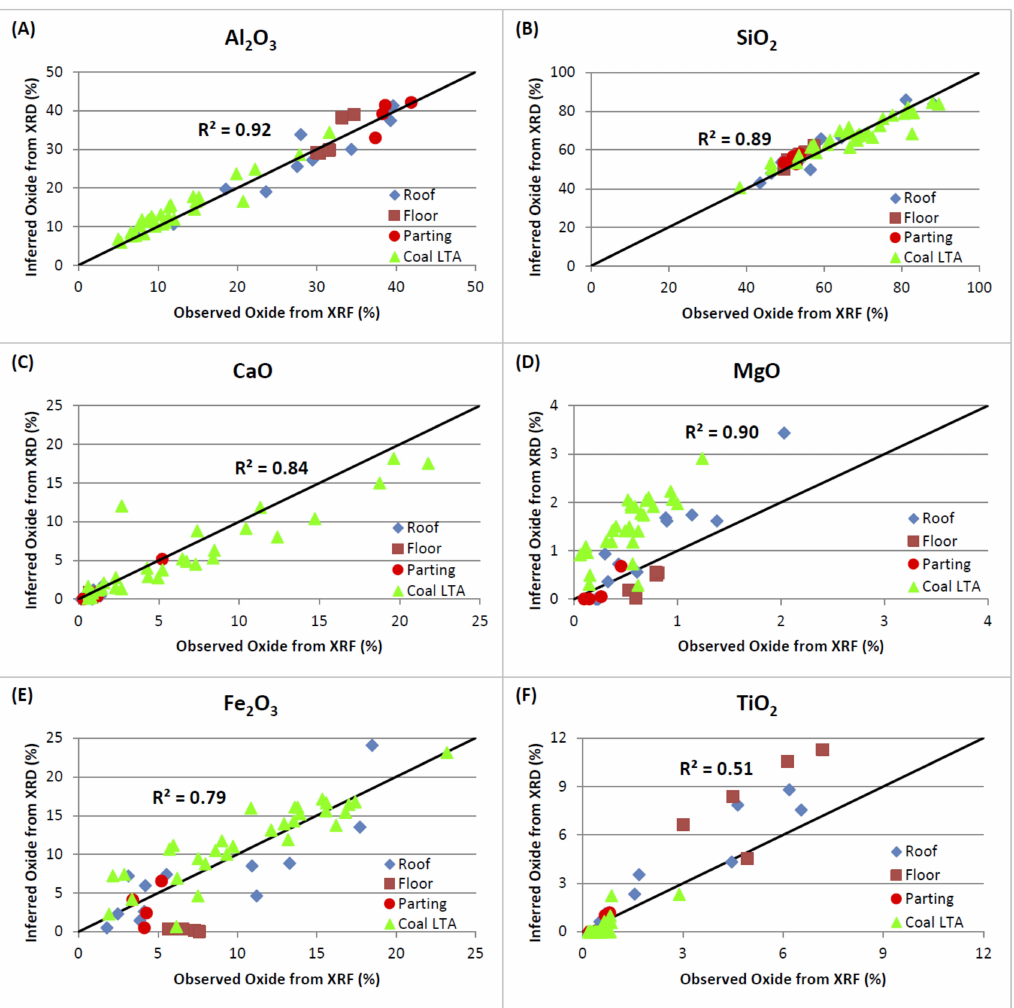
Figure 18. Comparison between the observed oxide percentages (normalized) from XRF and oxide percentages inferred from XRD analysis. The diagonal line in each plot indicates equality. ( A ), Al 2 O 3 ; ( B ), SiO 2 ; ( C ), CaO; ( D ), MgO; ( E ), Fe 2 O 3 ; ( F ), TiO 2